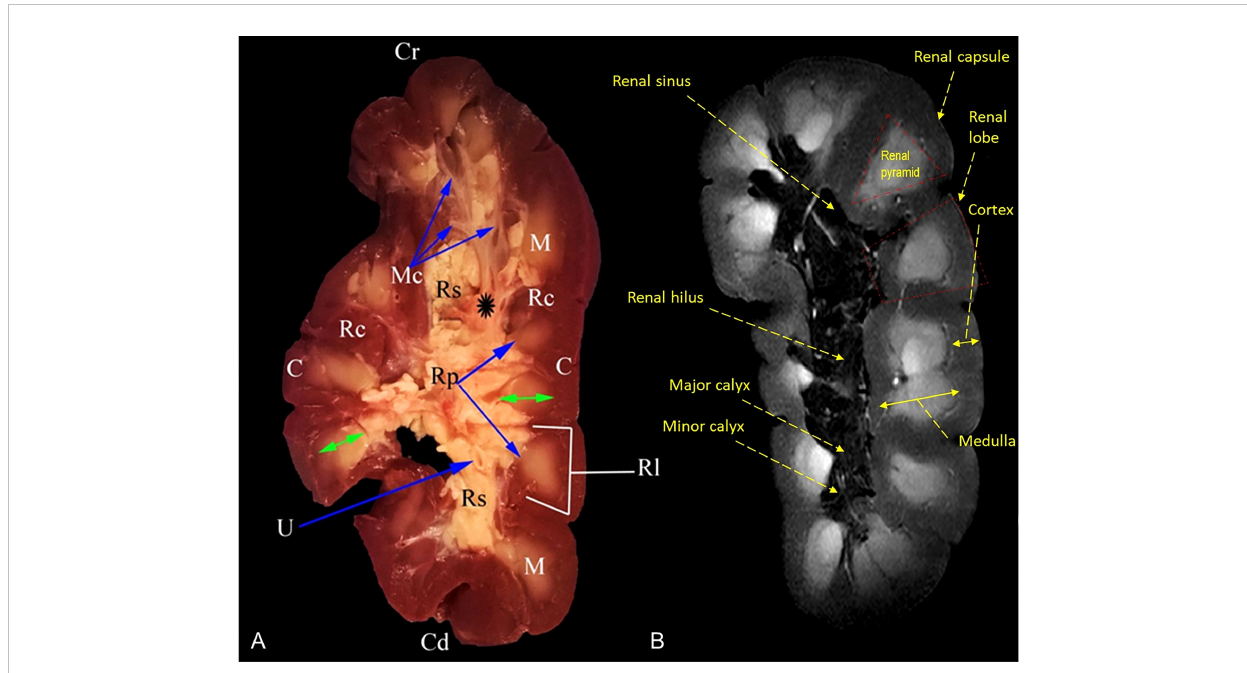
FIGURE 4 Representative mid-longitudinally sectioned gross image (A) and corresponding MR image (B) of the left kidney of oxen. Cr, cranial pole; Cd, caudal pole; RI, renal lobule; C, cortex; Rc, renal column; M, medulla; renal pyramid (double arrowhead); Rp, renal papillae; Rs, renal sinus; Mc: minor calyx; major calyx (asterisk symbol); U: ureter within fat tissue into the renal